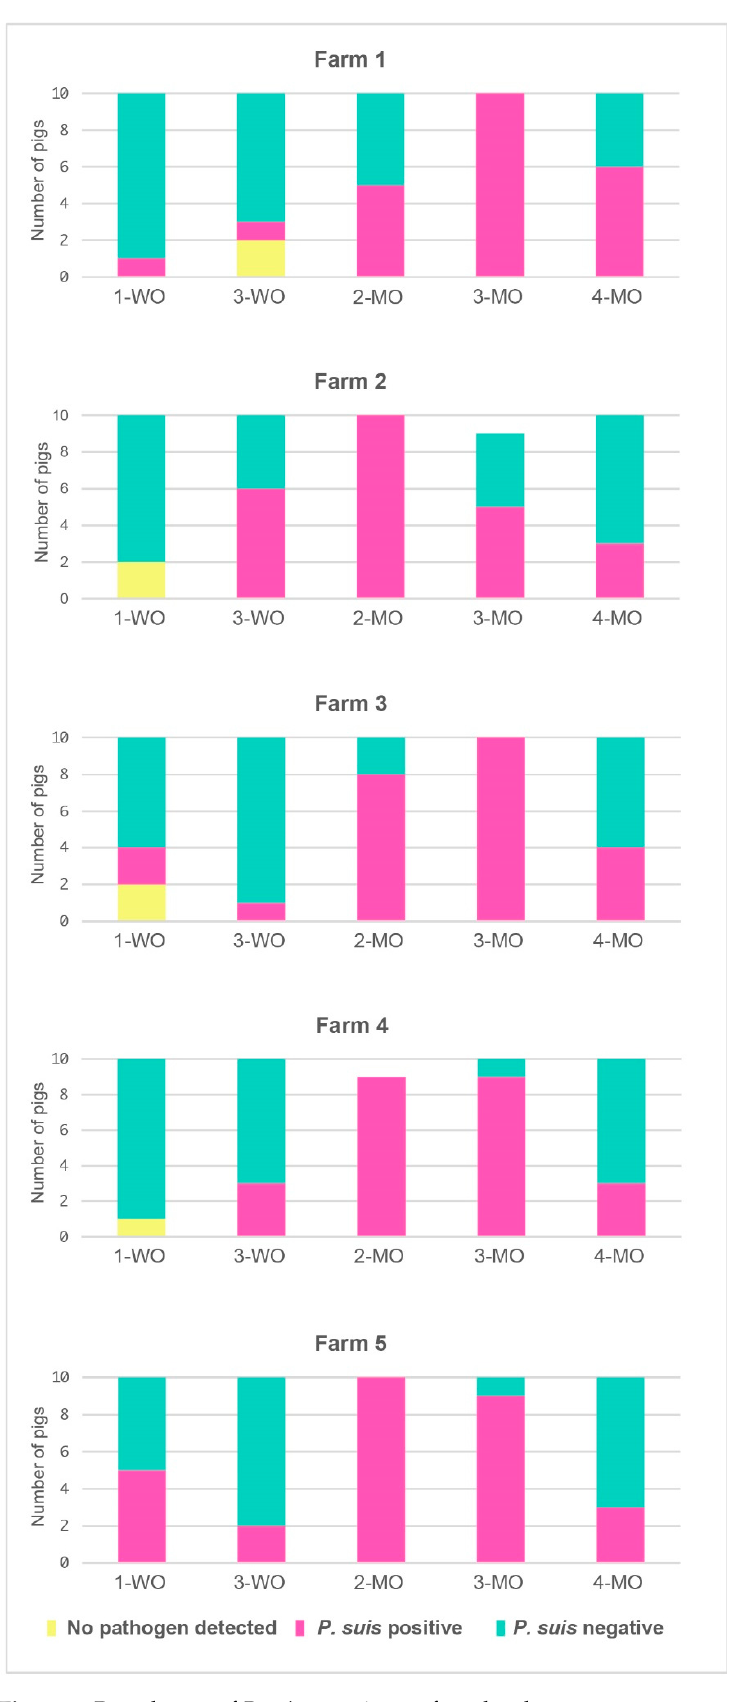
Figure 3. Prevalences of P. suis over time at farm level.